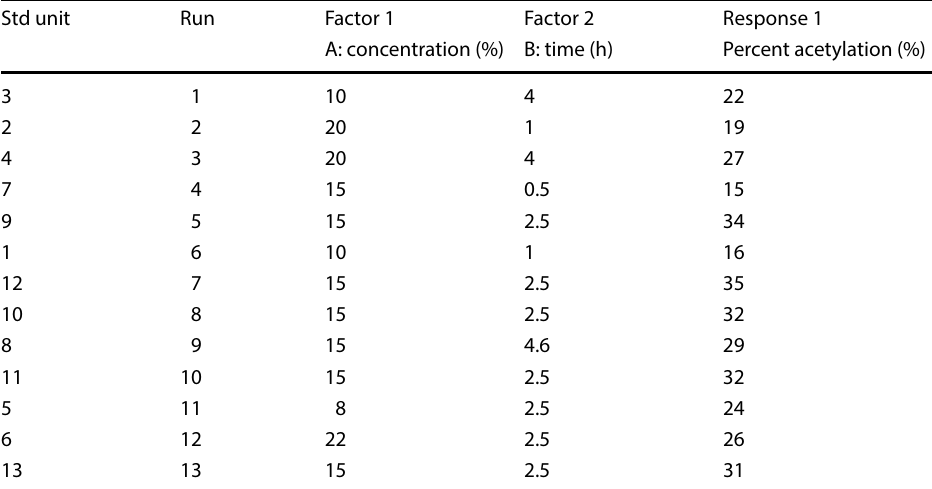
Table 1 Experimental design for PC blend acetylation process at different parameter